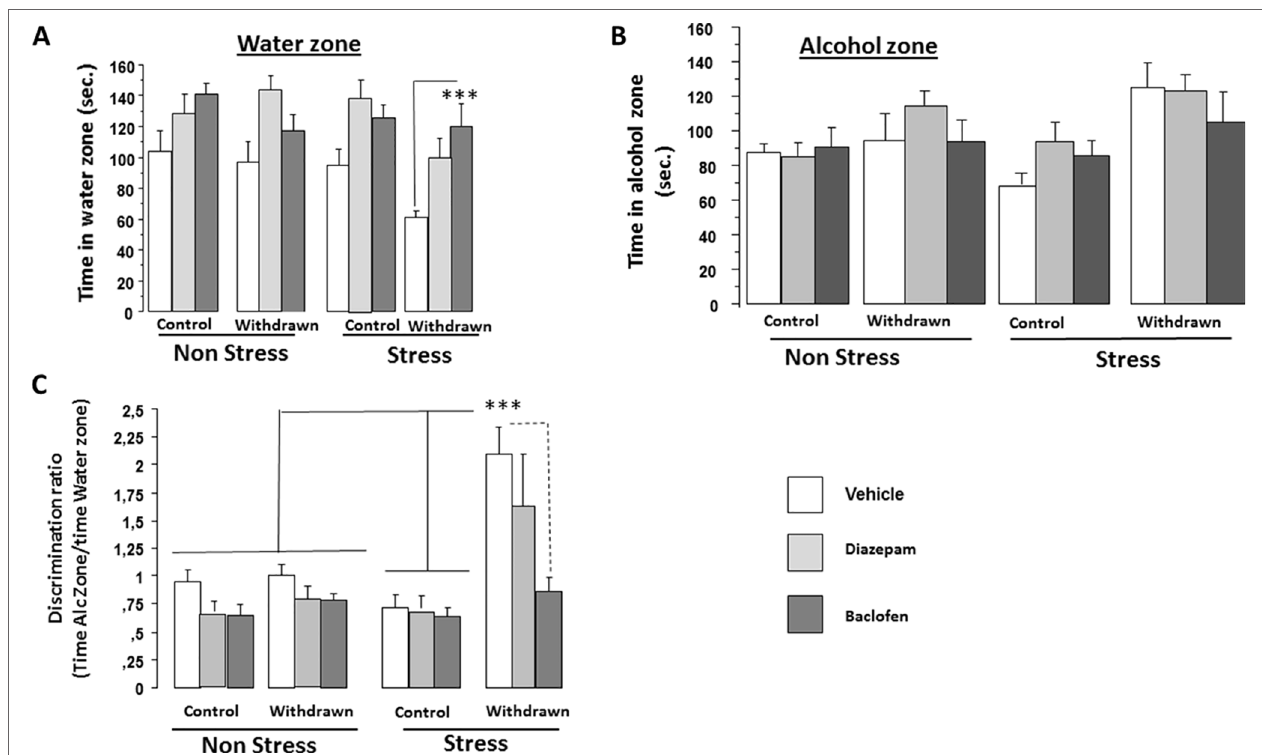
FIGURE 6 | Pharmacological experiment. Experiment 3 was carried out on independent groups not used in Experiment 2 as follows: Vehicle-withdrawn mice ( N = 9 and N = 8 in stress and non-stress conditions, respectively), diazepam-treated withdrawn mice ( N = 7 in both stress and non-stress conditions), and baclofen- treated withdrawn animals ( N = 7 in both stress and non-stress conditions) were compared to control mice also submitted to repeated injections of either vehicle ( N = 10 in both stress and non-stress conditions), diazepam ( N = 8 in both stress and non-stress conditions), or baclofen ( N = 9 and N = 8 in stress and non-stress conditions, respectively). Results are expressed as mean ± SEM. Time spent in the water zone (A): no significant between-group difference was observed in non-stressed groups ( p > 0.05 in all analyses); in contrast, in stressed groups, baclofen-treated withdrawn mice exhibited a higher exploration time in the water zone as compared to vehicle-treated withdrawn mice (*** p < 0.001). Time spent in the alcohol zone (B): no significant between-group difference was observed in both non-stress and stress conditions ( p > 0.05). Discrimination ratio (C) (time spent in the alcohol zone/time spent in the water zone): Vehicle-treated withdrawn mice exhibited a significantly higher discrimination ratio as compared to all groups (*** p < 0.001 in all comparisons) except diazepam-stressed withdrawn